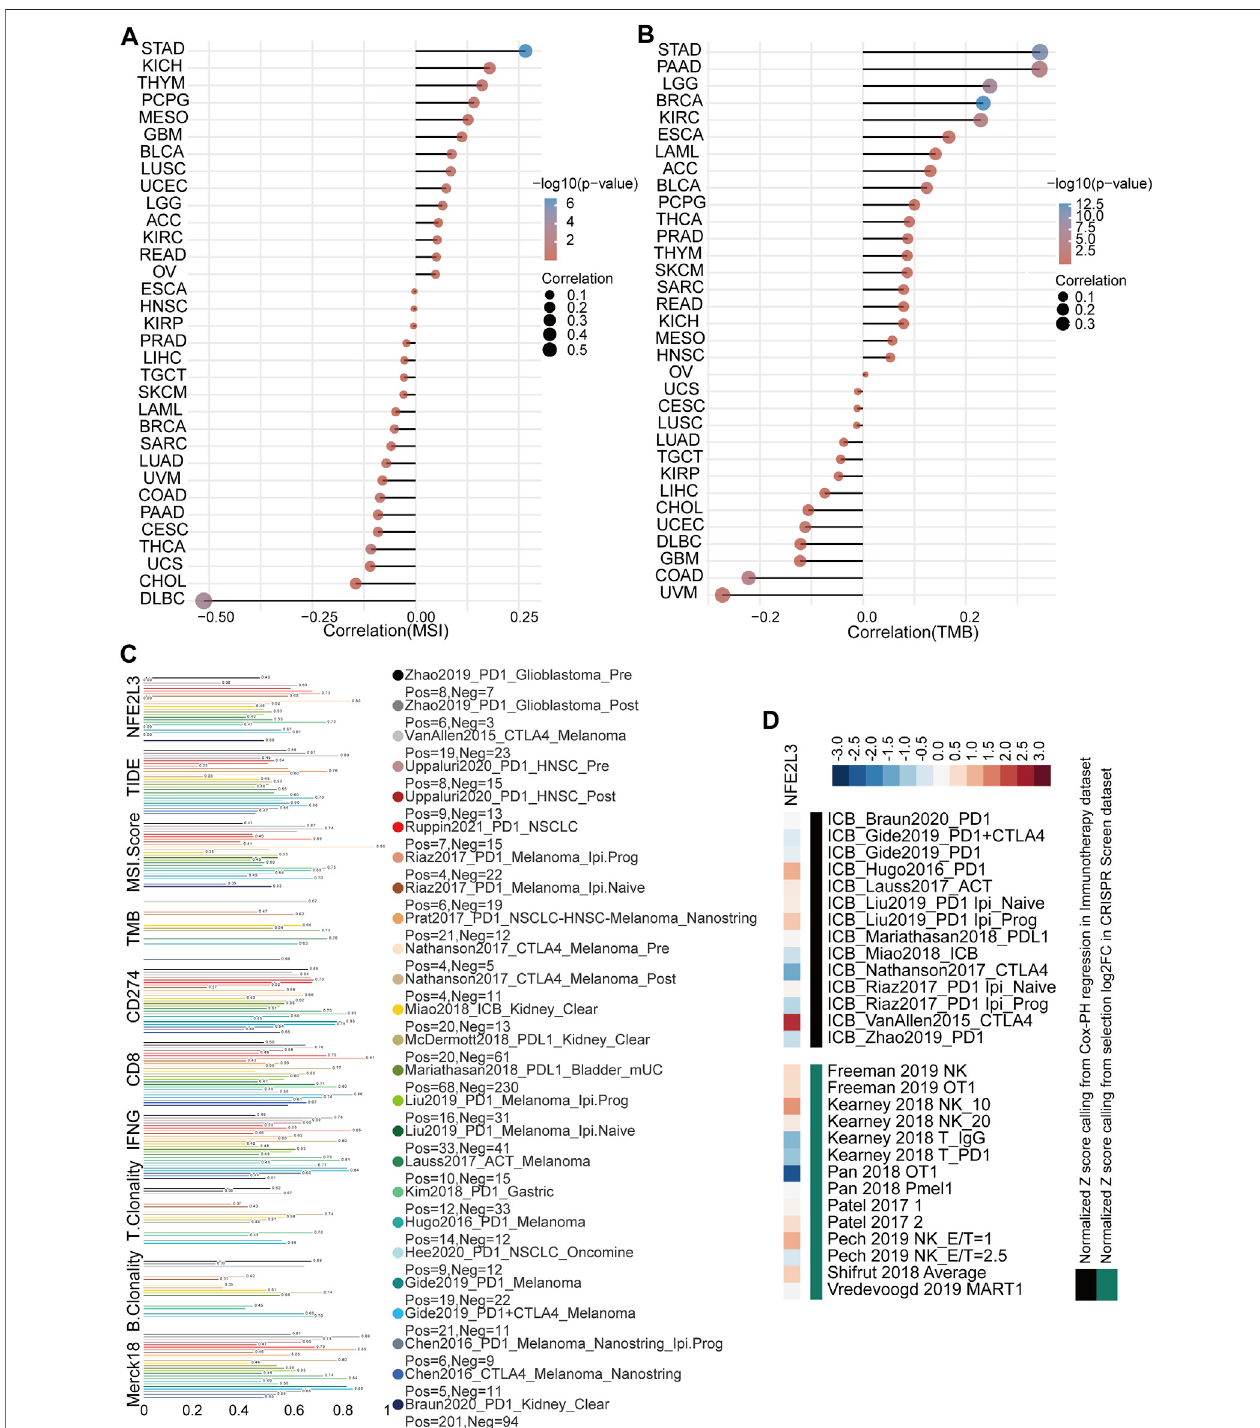
FIGURE8| Immunotherapyresponseanalysisinpan-cancer. (A) ThecorrelationbetweenNFE2L3expressionandMSIinpan-cancer. (B) Thecorrelationbetween NFE2L3 expression and TMB in pan-cancer. (C) The potential of NFE2L3 as a biomarker to predict response to immune checkpoint blockade. (D) NFE2L3 was ranked by its weighted average value across the association with ICB survival outcome and log-fold change (logFC) in CRISPR screens.